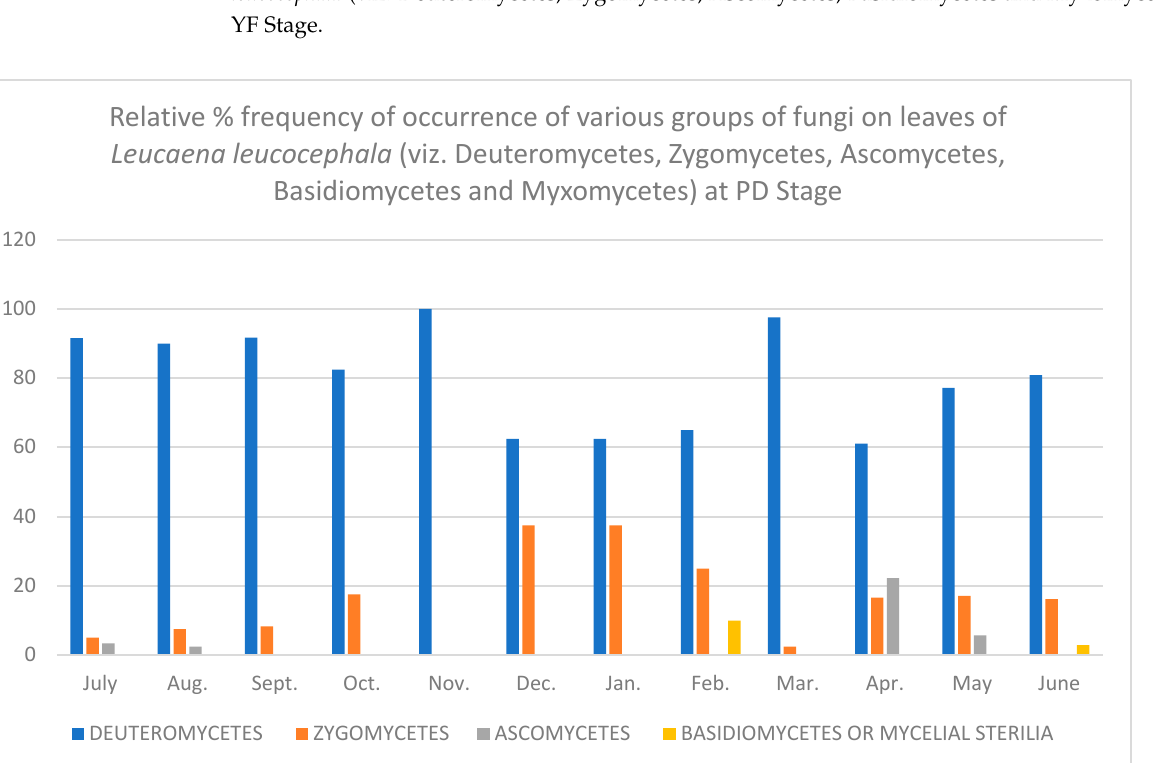
Figure 5. Relative % frequency of occurrence of various groups of fungi on leaves of Leucaena leucocephala (viz. Deuteromycetes, Zygomycetes, Ascomycetes, Basidiomycetes and Myxomycetes) at PD Stage. Table 6. Percentage frequency of occurrence of various fungi on completely decomposed leaves (CD).